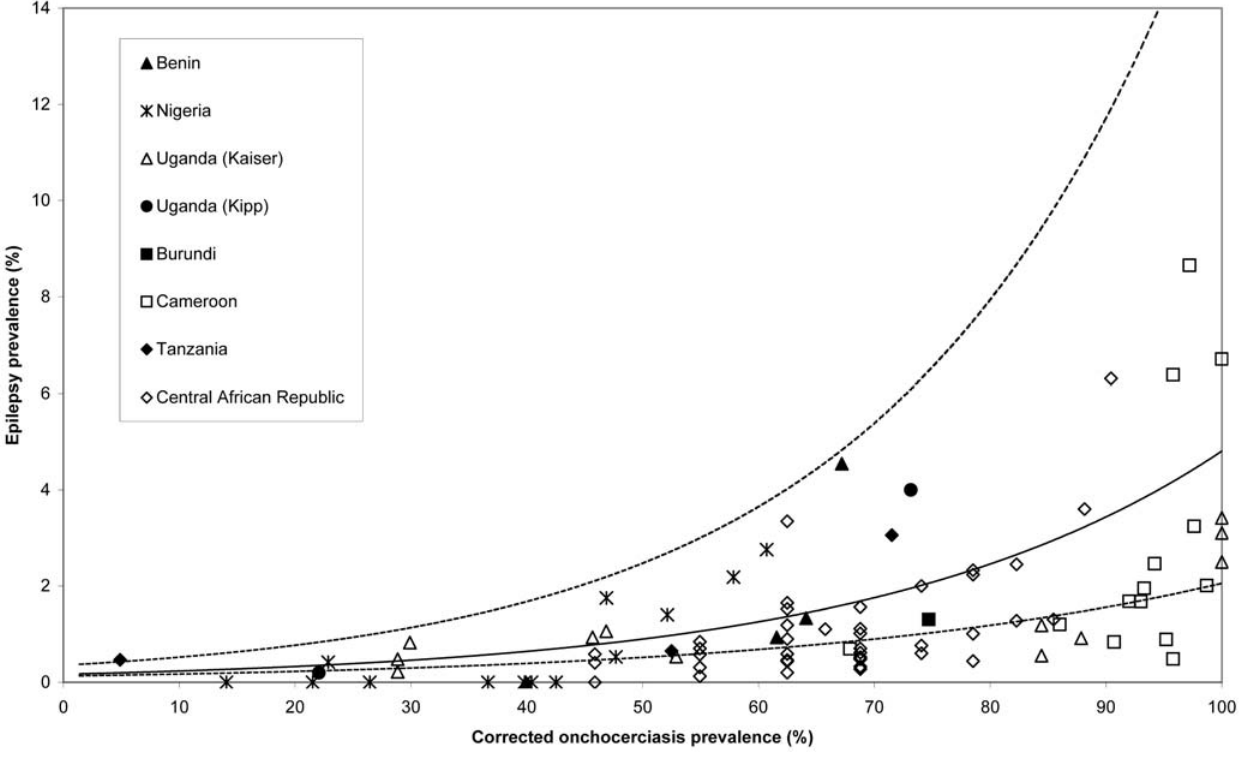
Figure 3. Epilepsy prevalence vs corrected onchocerciasis prevalence (see Supporting Information for details on correction factors). Solid line: predicted relationship estimated by random-effect logistic regression; dashed lines: 95% confidence interval of the model predictions.